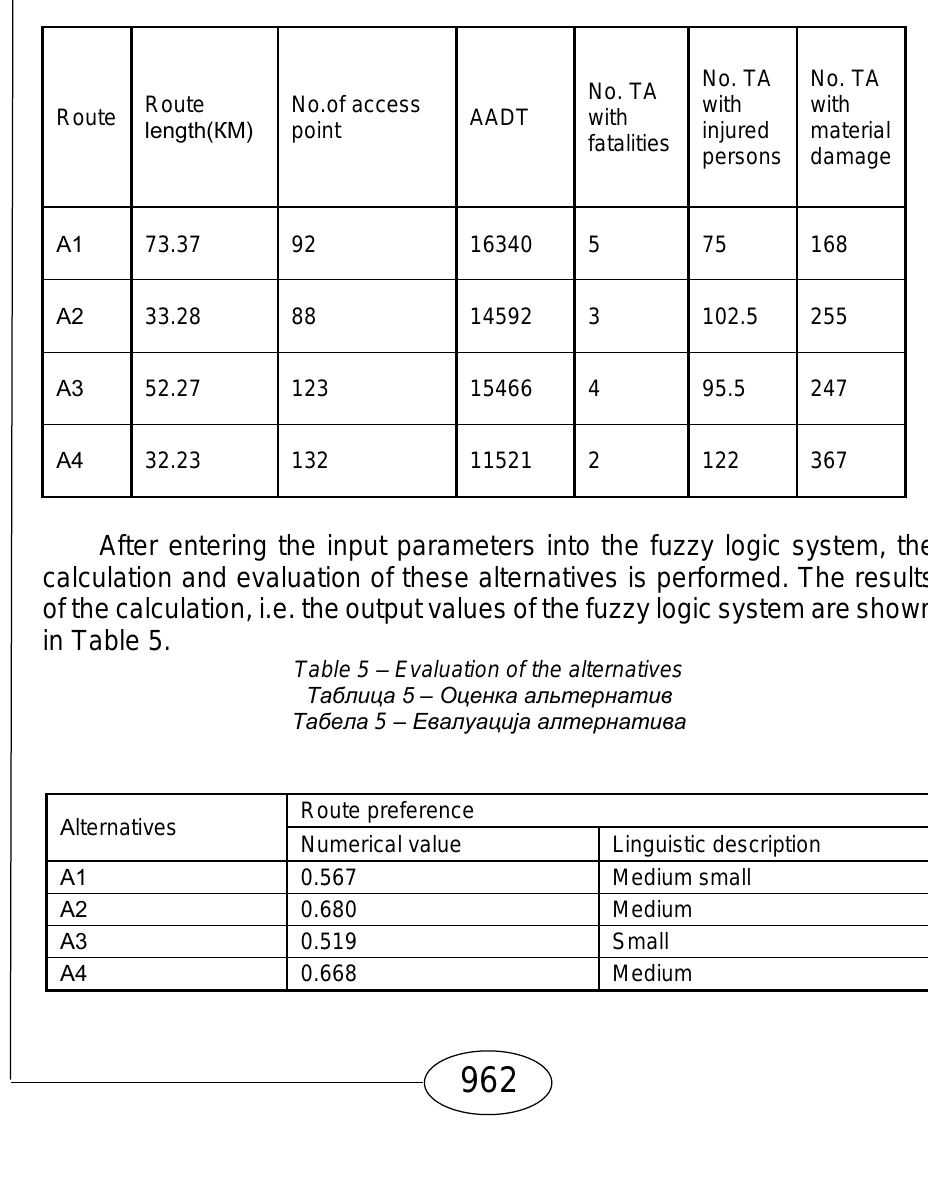
Table 4 – Values of the input variables in the fuzzy logic system